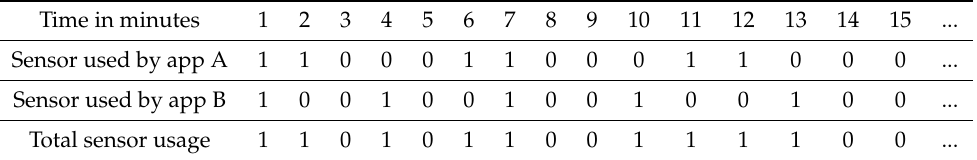
Table 1. Activation pattern of a sensor used by two applications allowing to compute the energy consumption of the sensor. The first row is the time, the three other rows are the activation state of the sensor, with 1 for the activated state and 0 for the disabled